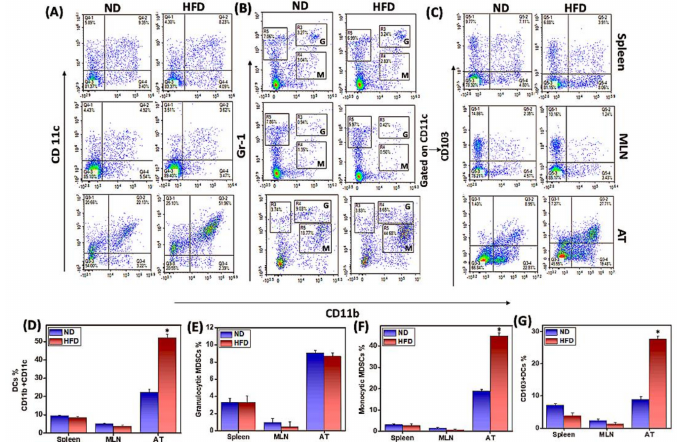
Figure 2. HFD induces M1 macrophages (CD11b + CD11c + ), monocytic MDSCs (CD11b + LY6c High LY6g Low ), and CD11b + CD103 + dendritic cells (DCs) in adipose tissue (AT). Mice were fed HFD or ND for 12 weeks before sacrifice. Spleens, mesenteric lymph nodes (MLNs), and epididymal adipose tissue (AT) were harvested from each group of mice and single-cell suspensions were prepared from each organ using a tissue stomacher and analyzed by flow cytometry. Changes in the frequency of ( A ) M1 macrophages, ( B ) granulocytic (G) or monocytic (M) myeloid-derived suppressor cells (MDSCs), and ( C ) CD103 + dendritic cells from HFD-fed mice flow cytometry data were expressed as the mean percentage of cells/mouse ± SEM in a bar graph ( A – D , B – E , M – F , C – G ). Data shown are from a representative experiment; three independent experiments involving six mice/groups yielded similar results. Asterisks (*) indicate statistically significant differences ( p < 0.01) between ND and HFD